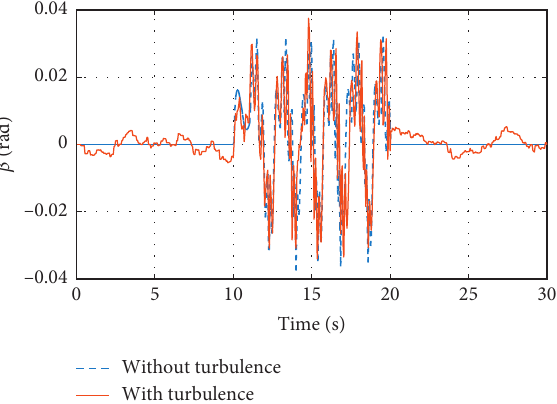
Figure 9: The difference of sideslip angle with the time.